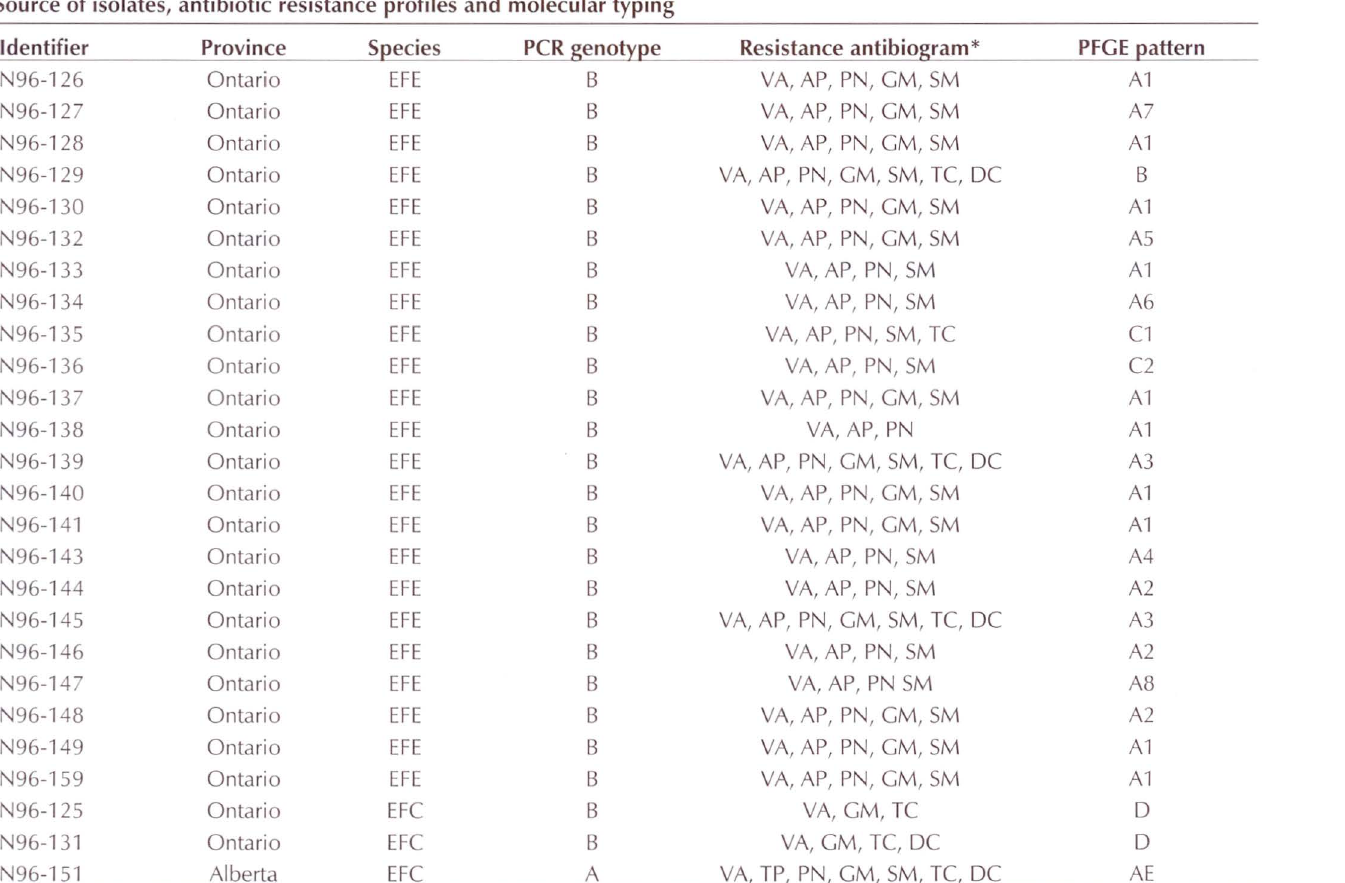
Source of isolates, antibiotic resistance profiles and molecular